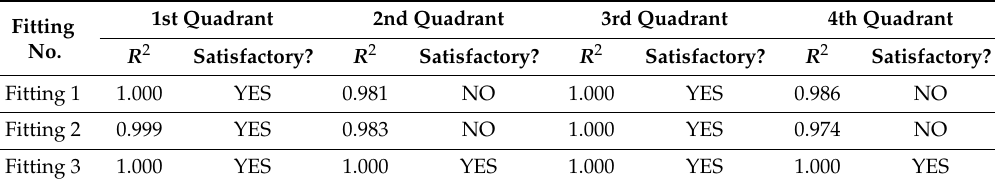
Table 9. Goodness of fit for the case of the damaged hull due to collision.